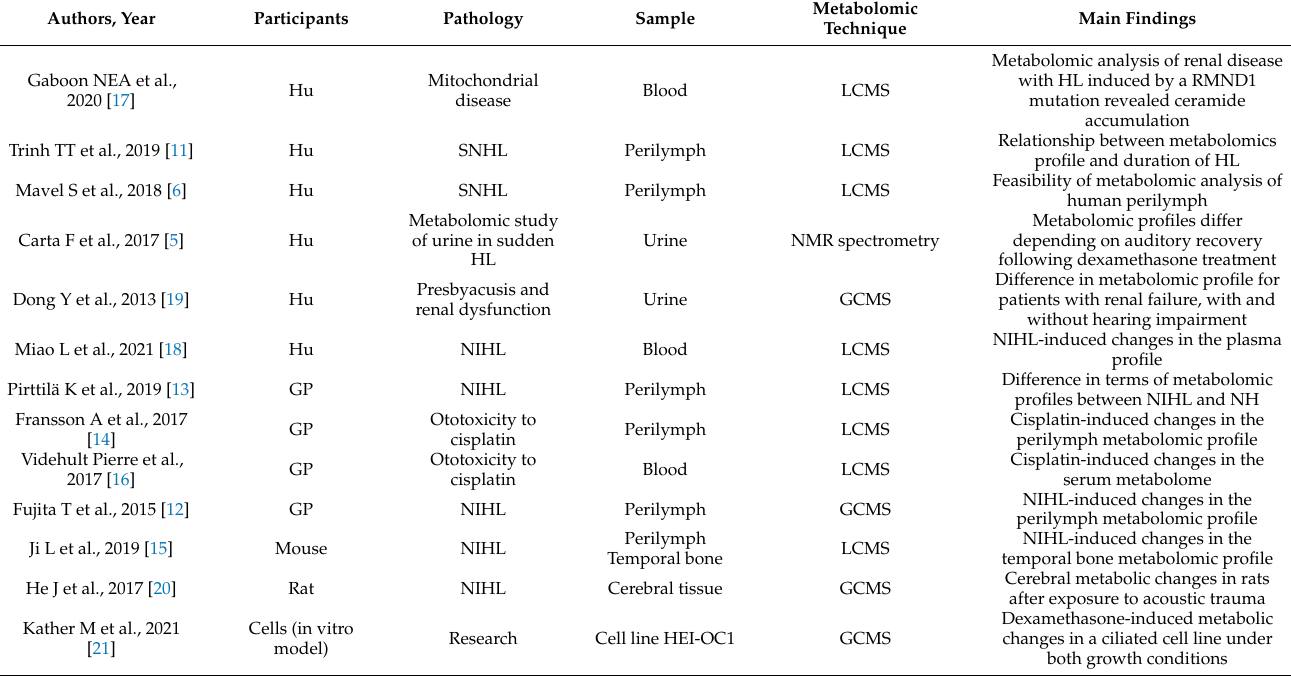
Table 1. Studies according to publication journal, animal type, subject, pathology type, sample type, and metabolomic analysis